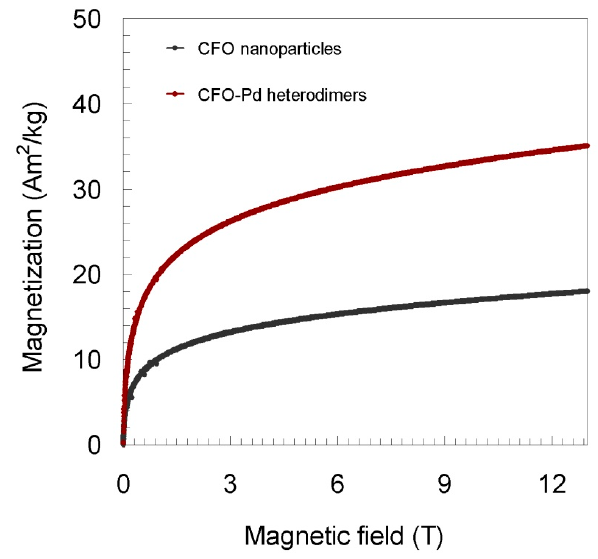
Figure 7. M-H curves of superparamagnetic CoFe 2 O 4 nanoparticles (CFO, mean hydrodynamic size: 24 nm) and CoFe 2 O 4 -Pd (CFO-Pd, mean particles size of Pd: 2 nm) heterodimers measured by vibrating sample magnetometer (VSM) magnetometry at 300 K.